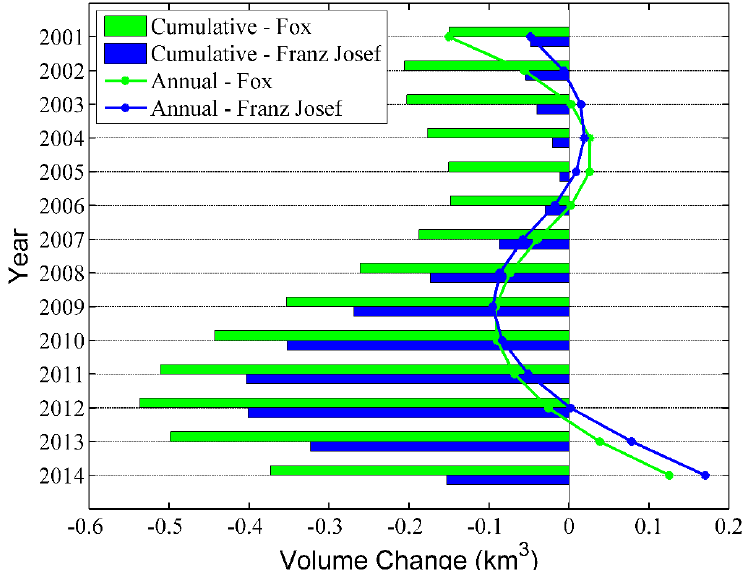
Figure 9. Annual (dot line) and total (bar) volume change of Fox Glacier (green) and Franz Josef Glacier (blue) between 2000 and 2014. The year in the Y-axis refers to 1 January of the ending